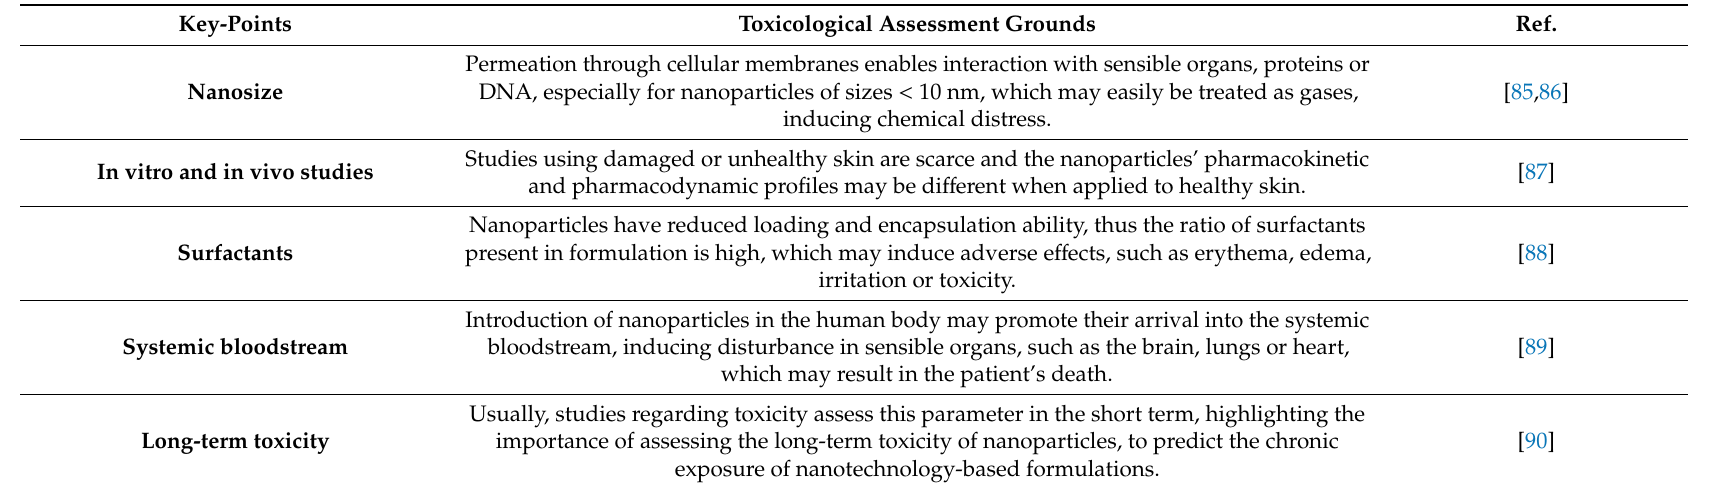
Table 3. Toxicological key points related to nanotechnology-based